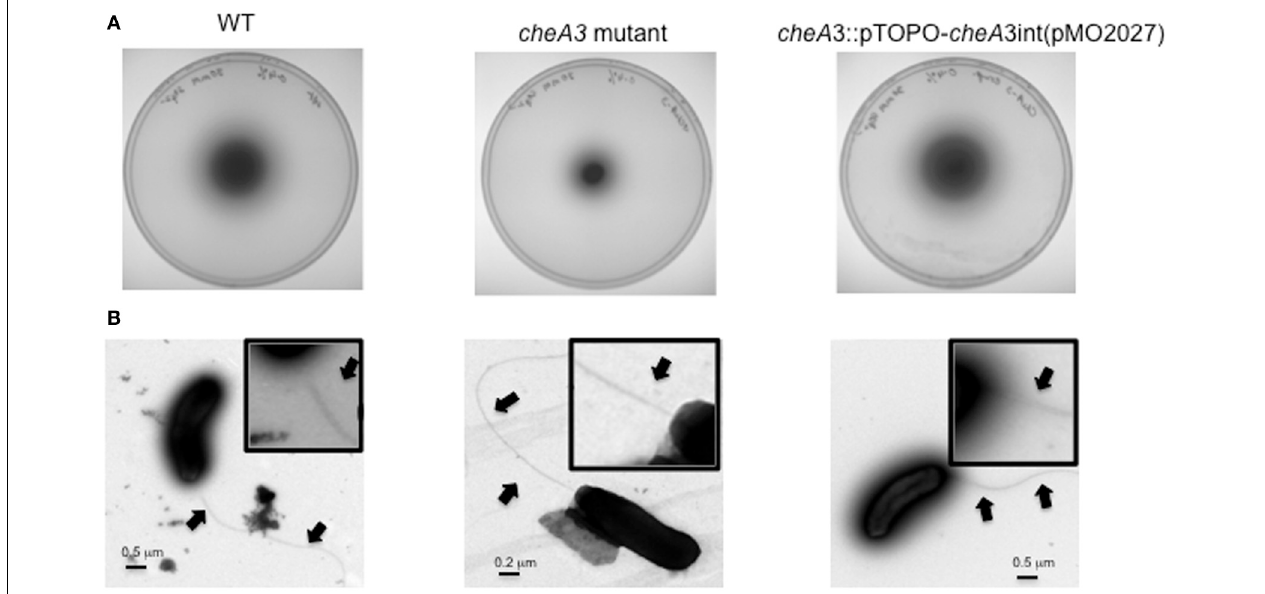
FIGURE 2 | (A) Soft agar plate assays of D. vulgaris wild type, cheA3 mutant and cheA3 complement strain, cheA3:: pTOPO -cheA3int (pMO2027) in LS4D medium with 0.4% (wt/vol) agar and 30mM sulfate. (B) Transmission electron